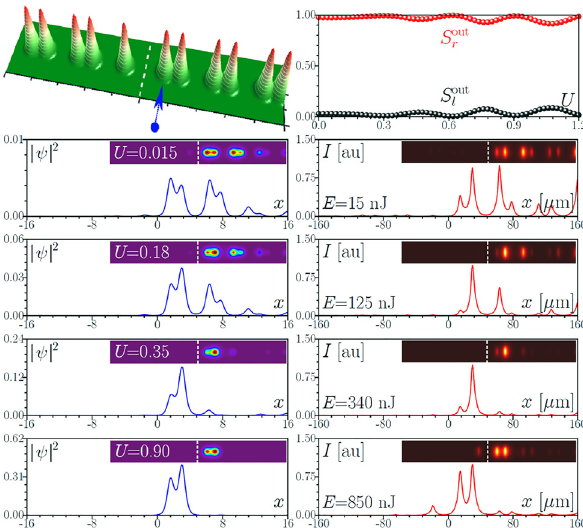
Figure 6: Same as in Figure 5, but for the excitation of the left outermost waveguide in the nontopological array.